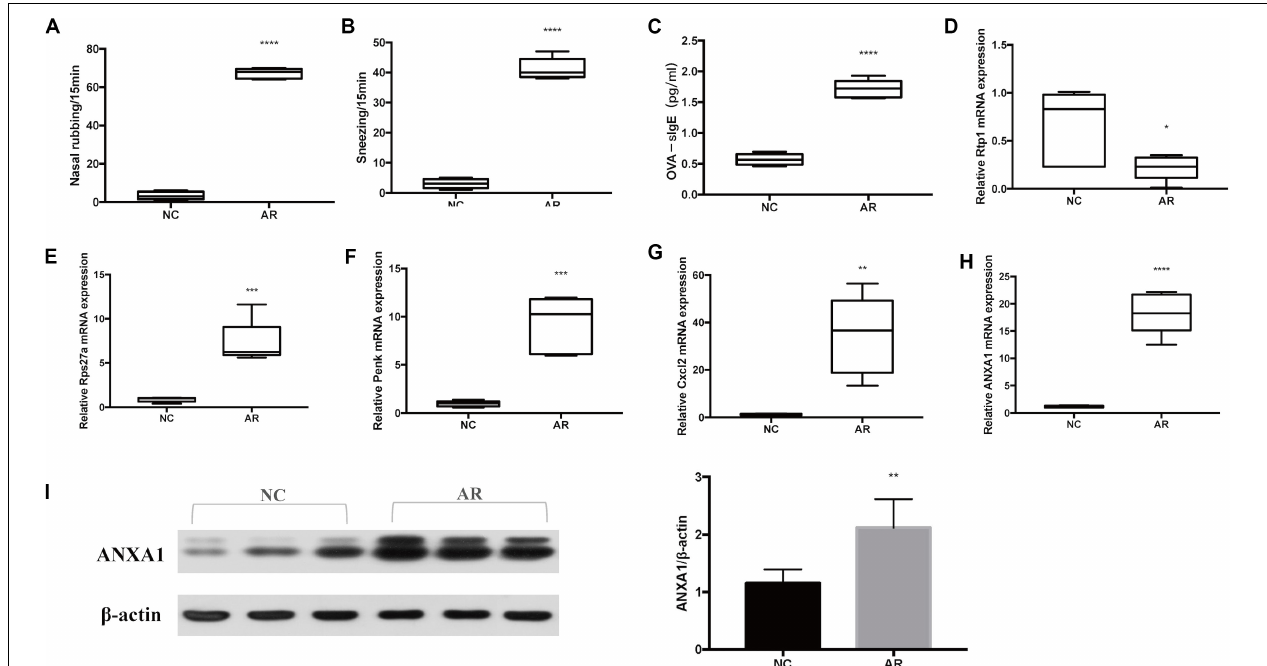
FIGURE 5 | Murine model results. (A) Symptom score of sneezing. (B) Symptom score of nose rubbing. (C) Serum OVA-specific IgE was assayed by ELISA. The mRNA level of (D) Rtp1, (E) Rps27a, (F) Penk, (G) Cxcl2, and (H) Anxa1. (I) Western blot results of ANXA1 of nasal tissues and the densitometric analysis result. ****p < 0.0001, ***p < 0.001, **p < 0.01, *p <